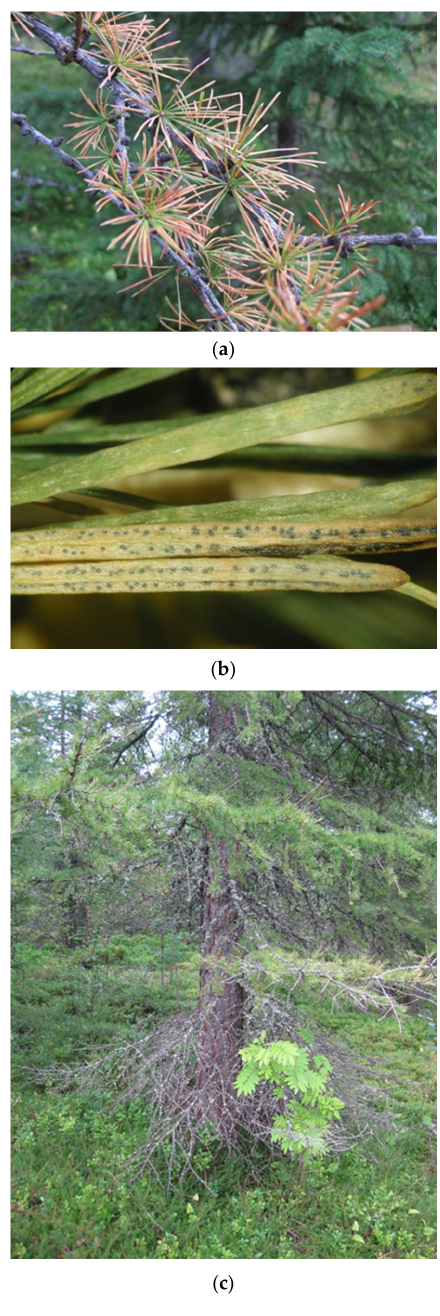
Figure 3. ( a ) Symptoms of Mycosphaerella laricina on Siberian larch needles in Kivalo Research Forest, Rovaniemi, 11 August, 2011; ( b ) Asexual state of Mycosphaerella laricina on Siberian larch needles in Maaninkavaara, Kuusamo, 23 August 2013; ( c ) Crown-thinning in the lower canopy of a Siberian larch caused by severe subsequent infections of Mycosphaerella laricina in Kivalo Research Forest, Rovaniemi, 11 August